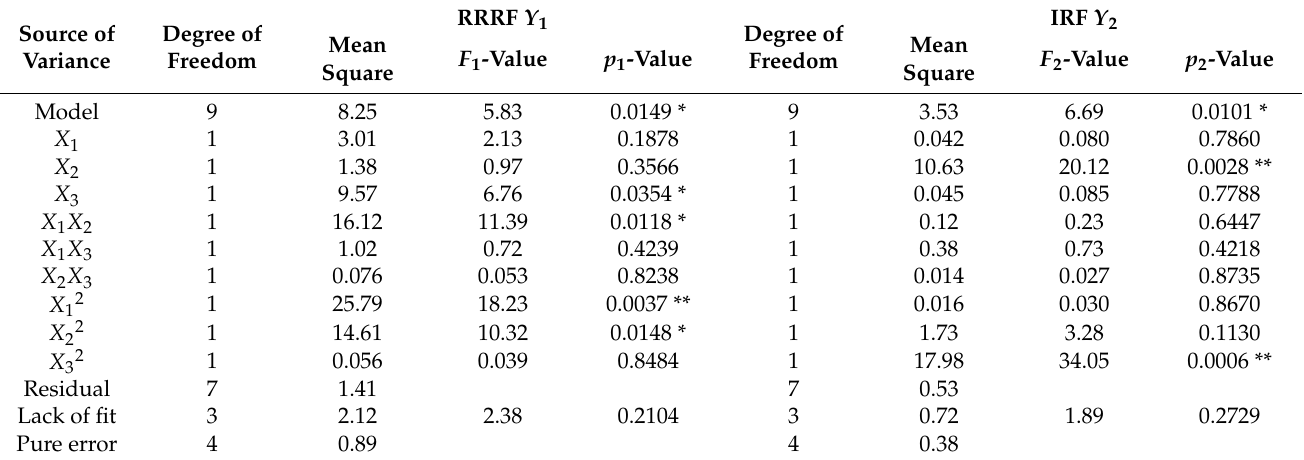
Table 3. Variance analysis of regression